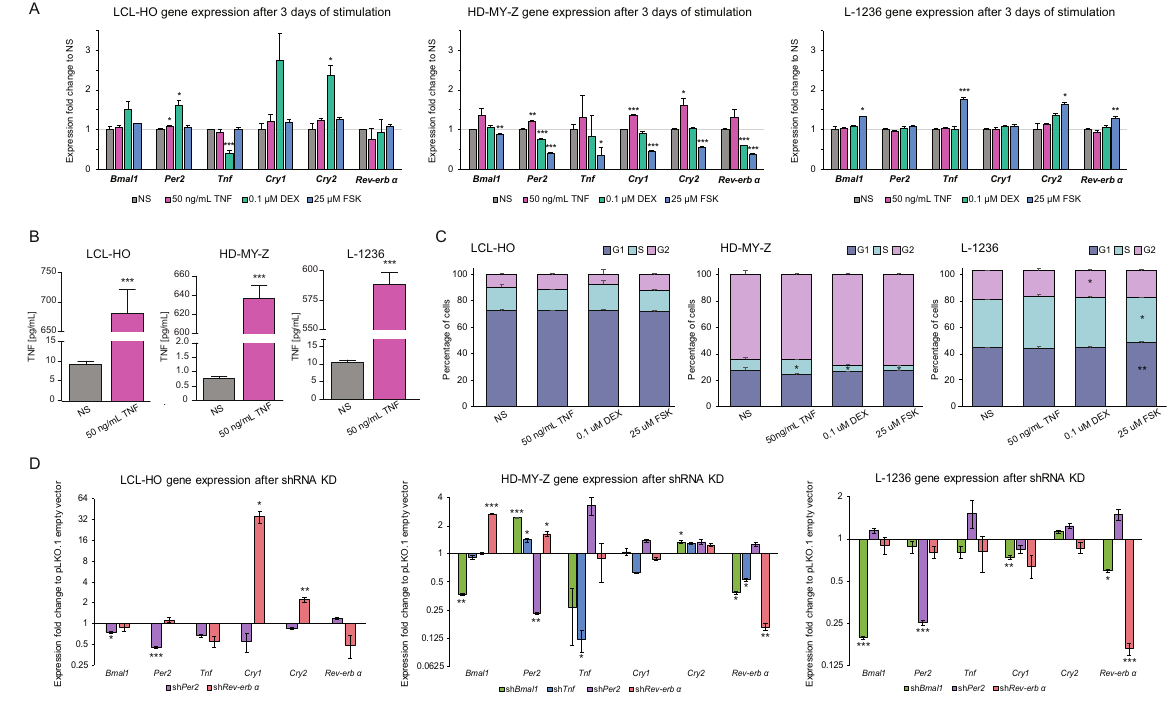
Figure 4. TNF affects the cell cycle and the expression of core-clock genes in HL. Gene expression, supernatant concentration of TNF and cell cycle analysis for the three cell lines (WT) after three days of stimulation with 50 ng/mL of recombinant human TNF, 0.1 uM dexamethasone and 25 uM of Forskolin. ( A ) Gene expression qPCR data (n = 3, mean ± SEM). ( B ) Supernatant concentration of TNF (n = 3, mean ± SEM). ( C ) Cell cycle analysis for the three cell lines (LCL-HO, the HL cell line HD-MY-Z and the HL cell line L-1236) (n = 3, mean ± SEM). ( D ) Gene expression data for Bmal1 , Per2 , Tnf, Cry1 , Cry2 and Rev-erb α of LCL-HO, HD-MY-Z and L-1236 cell lines after shRNA KD (n = 3, mean ± SEM). The corresponding shRNA KD for the specific cell is represented under each plot. * p < 0.05, ** p < 0.01, *** p <